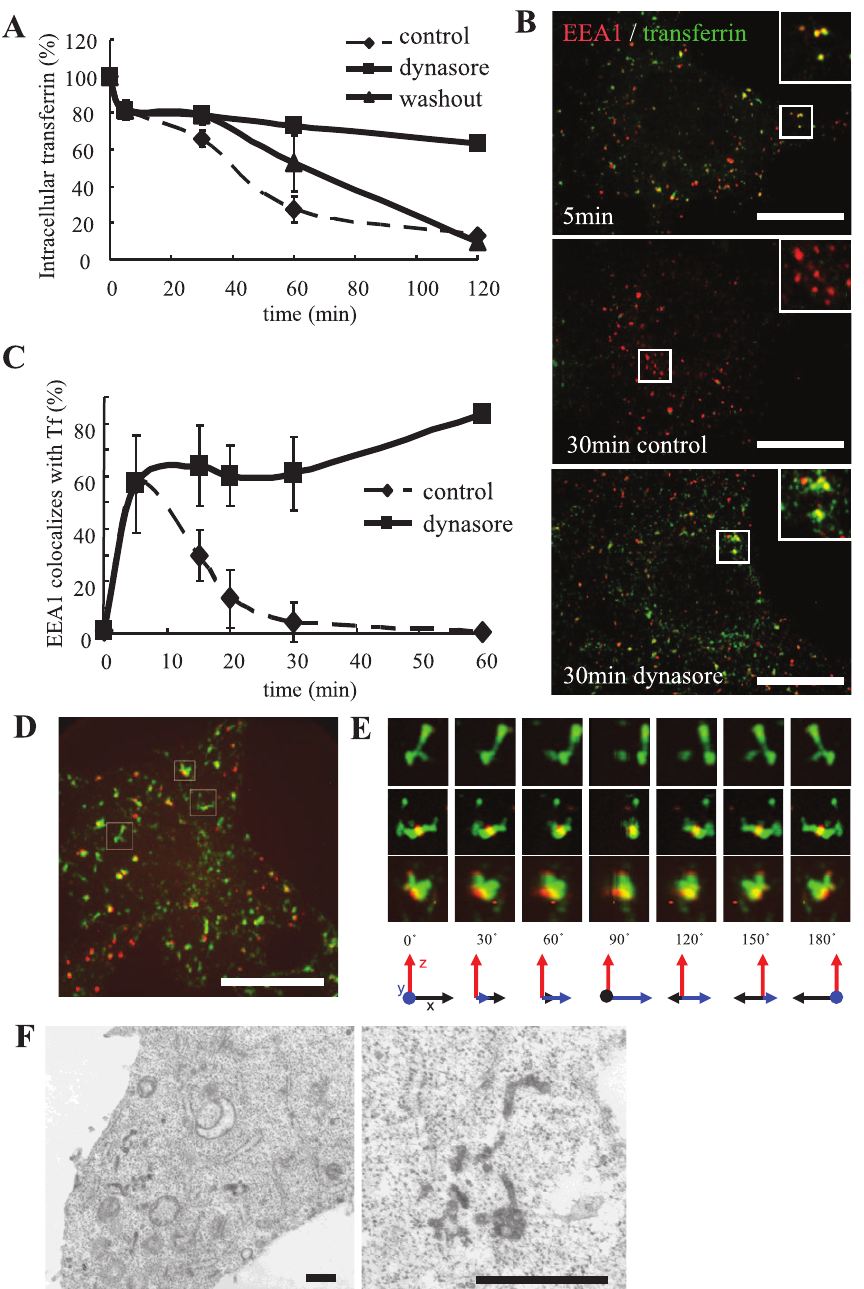
Figure 2. Dynasore inhibits transferrin recycling in early endosomes. A , Cells were incubated with biotin-conjugated transferrin on ice for 1 h, rinsed, and transferred to 37 u C. At each time point, cells were lysed and intracellular transferrin was measured by ELISA. In the ELISA assay, the cell lysates bound to plates coated with goat anti-transferrin antibodies (EY Laboratories, San Mateo, CA) and were detected with streptavidin-HRP. B , HeLa cells were incubated with Alexa 488-transferrin (Molecular Probes) on ice for 1 h, and then processed as in A . After 5 min, the media was changed to medium containing DMSO (control) or dynasore. At the time indicated, the cells were fixed and stained for EEA1 (BD Transduction Laboratories, San Jose, CA). Scale bar, 20 m m. C , Colocalization of EEA1 and transferrin was measured and is represented mean 6 S.D. N=20 cells. D , HeLa cells were bound with Alexa 555-EGF (Molecular Probes) and Alexa 488-transferrin on ice for 1 h. After rinsing, the cells were incubated at 37 u C for 5 min and dynasore was added. Thirty minutes after internalization, the cells were fixed and observed. Scale bar, 20 m m. Pictures were processed for 3D reconstruction using MetaMorph software ( E ). F , Cells were bound to HRP-transferrin and treated for 30 min as in D . The cells were then incubated in a DAB-containing solution on ice for 30 min, fixed, and processed for electron microscopy. Scale bar, 500 nm. doi:10.1371/journal.pone.0019764.g002 LAMP1, a marker for late endosomes/lysosomes (Fig. 4A, dynasore, EGF colocalized with EEA1 and not with LAMP1 Control). These EGF-containing endosomes were enlarged and (Fig. 4A). This indicated that EGF remained in the early located at the perinuclear region (Fig. 1B). Under the effect of endosome, and the EGF compartment did not mature to the late